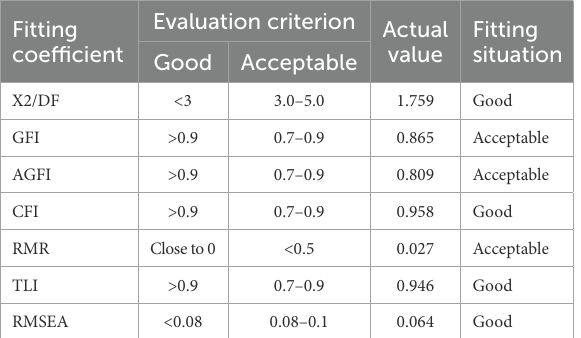
TABLE 3 Model fitness parameters. Fitting coefficient